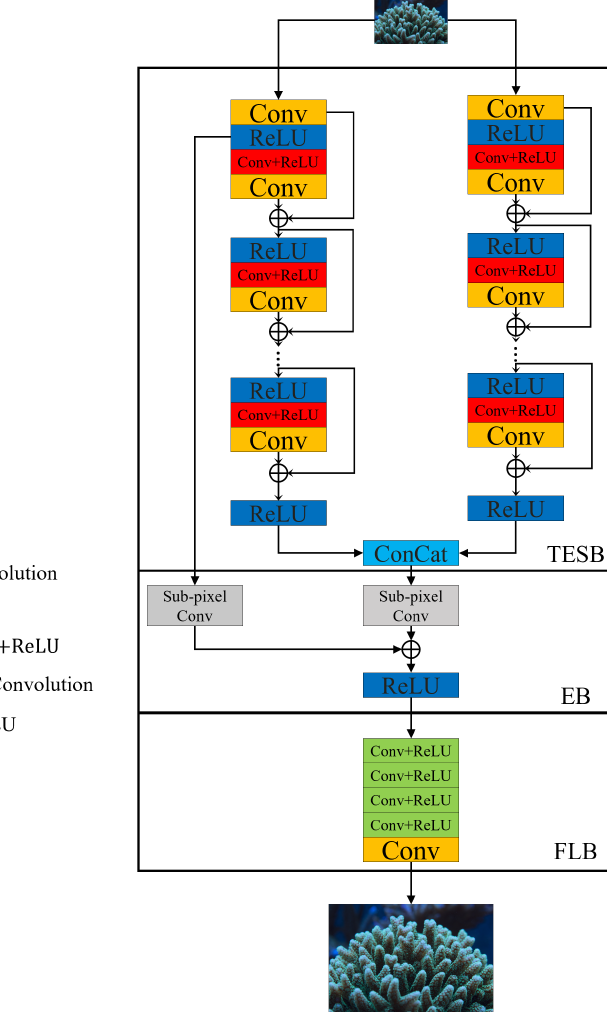
Figure 1. Network architecture of the proposed